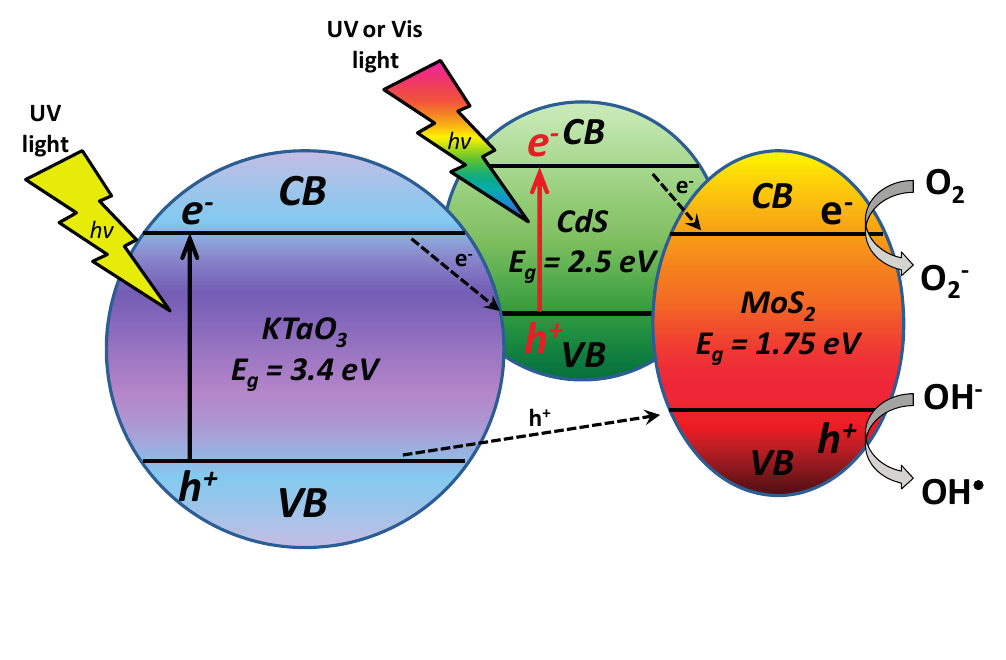
Figure 10. Probable UV-Vis two-photon excitation cycle of KTaO 3 -CdS-MoS 2 composite: (1) UV induced excitation in solid KTaO 3 ( E g = 3.4 eV) to generate free electrons ( e − )